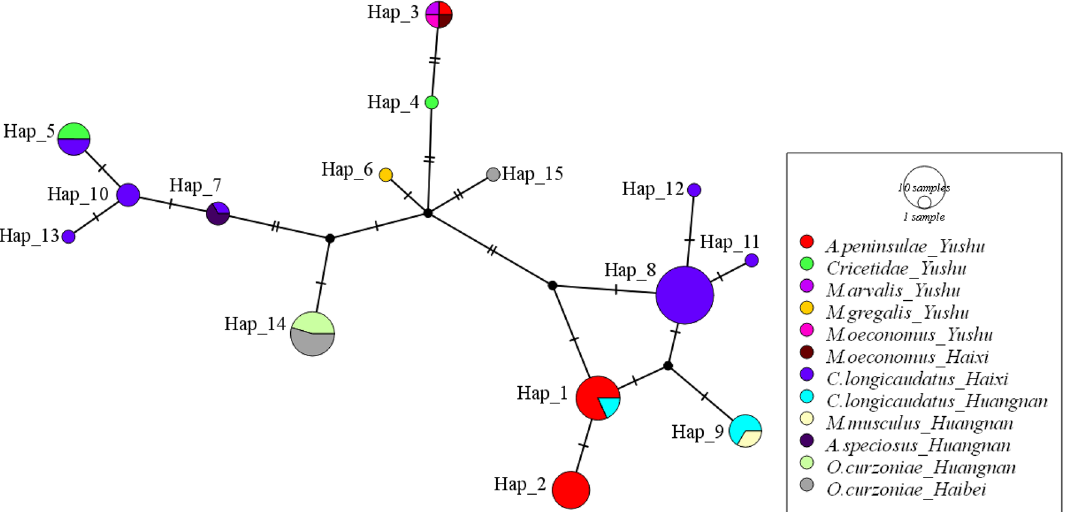
Figure 6. Median-joining networks of gltA gene for B. grahamii strains from different hosts and regions in the Qinghai-Tibetan Plateau, China. The sequences were analyzed based on a median-joining network using the Population Analysis with Reticulate Trees (PopART) software version 1.7 (http:// popart. otago. ac. nz/ index. shtml) with the default setting (epsilon =